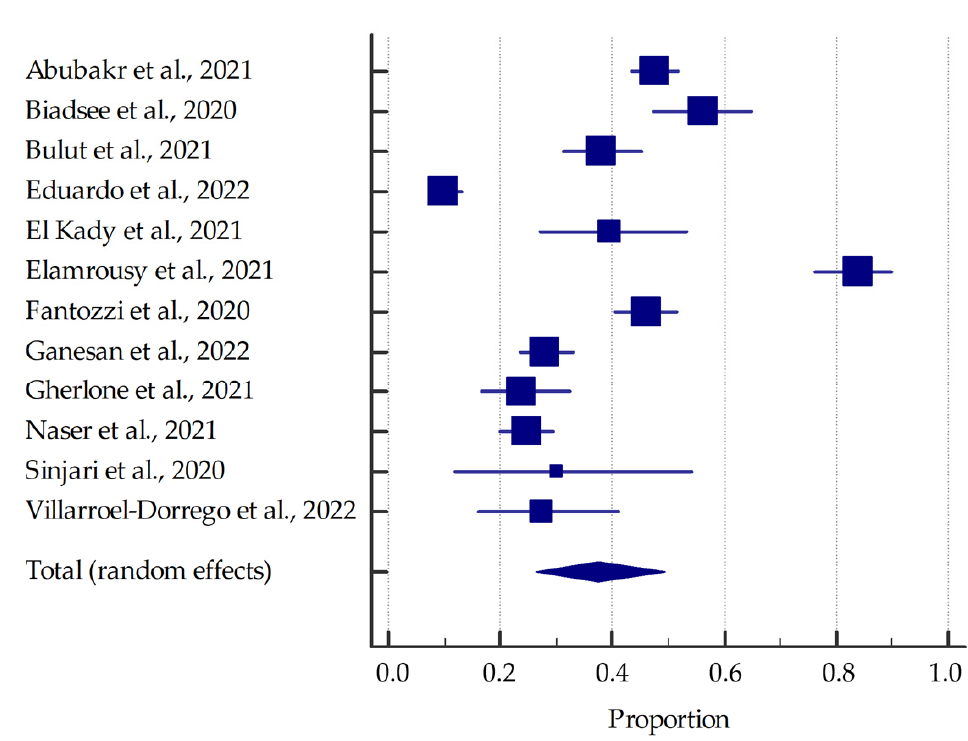
Figure 4. Forest plot presenting the summarized prevalence of xerostomia among SARS-CoV-2 positive individuals.